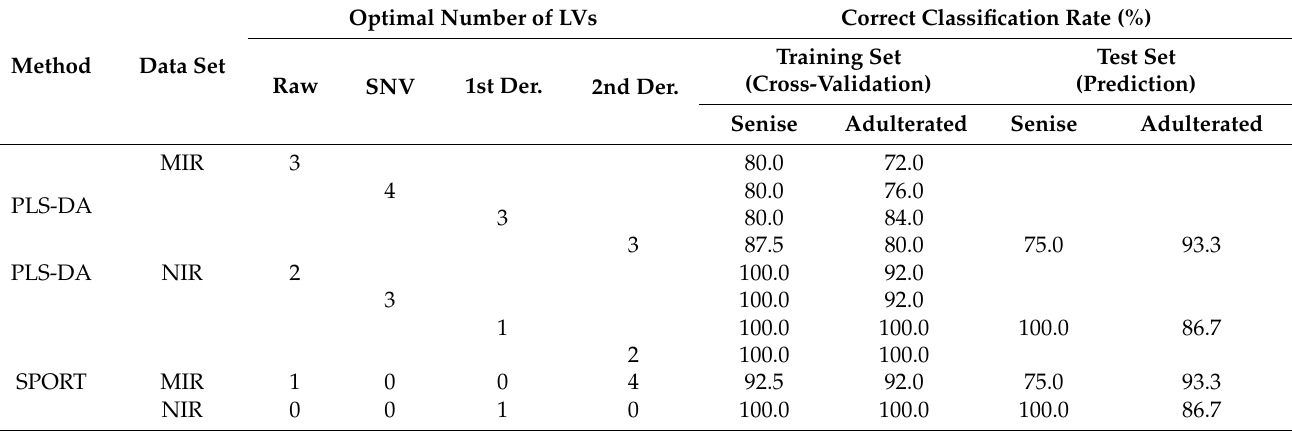
Table 2. Results of partial least squares-discriminant analysis (PLS-DA) and sequential preprocessing through orthogonal- ization (SPORT) classification for the MIR and the NIR data